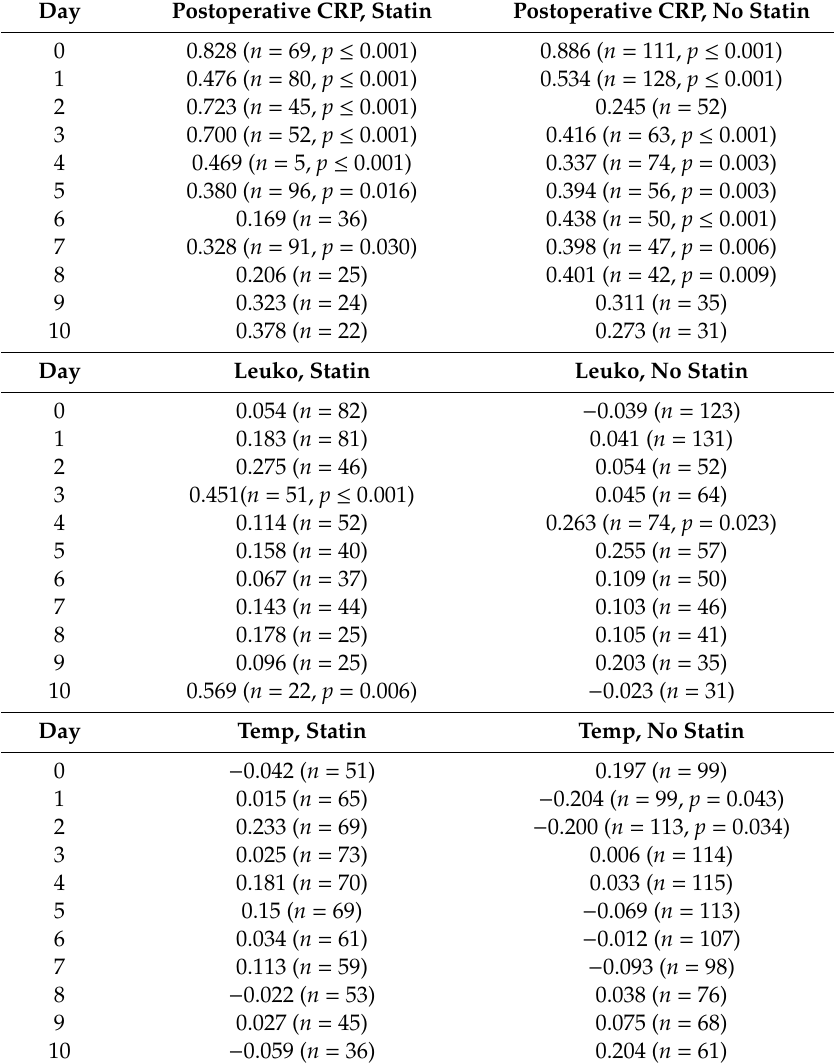
Table 5. Subgroup correlation analysis regarding statin